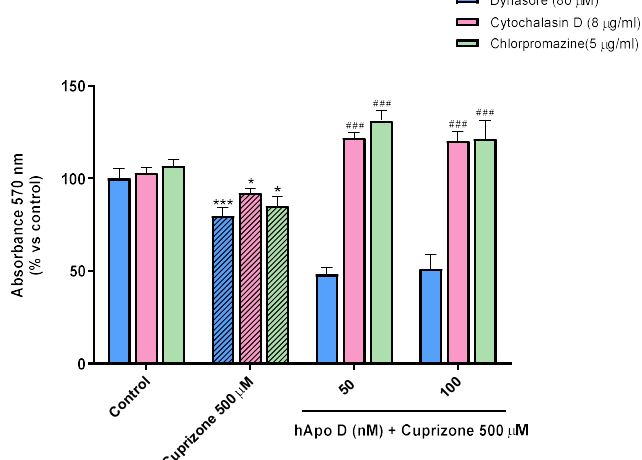
Figure 10. MTT assay in SH-SY5Y cells treated with 8 µg/mL cytochalasin D, 5 µg/mL chlorproma- zine hydrochloride, or 80 µM dynasore prior to the addition of increasing concentrations (50–100 nM) of hApo D for 24 h followed by 24 h with 500 µM of CPZ. Cell damage is represented as the percentage of viability versus control. Data are the mean ± SEM of five independent experiments. Significant differences were analyzed by a one-way ANOVA followed by post-hoc Tukey’s test.